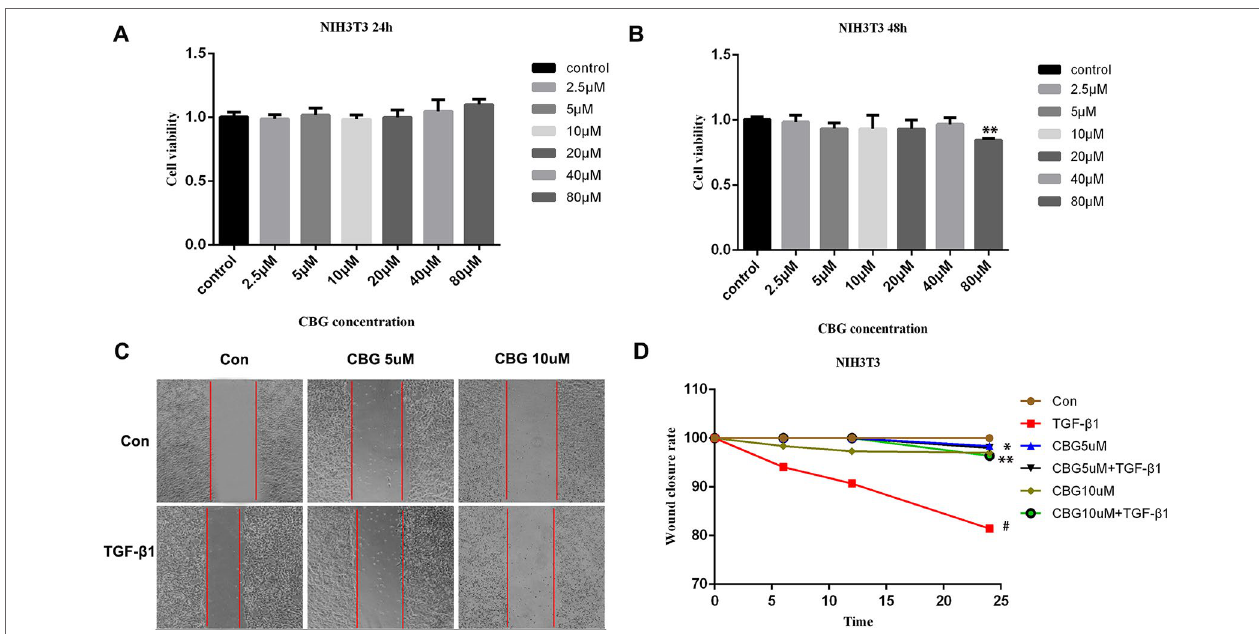
FIGURE 2 | Cinobufagin inhibits TGF- β 1-induced migration of lung fibroblasts. (A, B) NIH3T3 cells were treated with TGF- β 1 (5 ng·ml −1 ) and different doses of cinobufagin for 24 h. Cells treated with DMSO served as controls. Cinobufagin was measured by MTT value-added assays at 24 and 48 h to determine the inhibitory effect of cinobufagin on fibroblast proliferation induced by TGF- β 1 (n = 5 per group). (C, D) A wound healing assay was used to assess the effect of cinobufagin on fibroblast migration. The wound closure was photographed at 0, 12, and 24 h post-scratching (n = 3 per group). Experiments were performed in triplicate. *P < 0.05; **P < 0.01; # P <